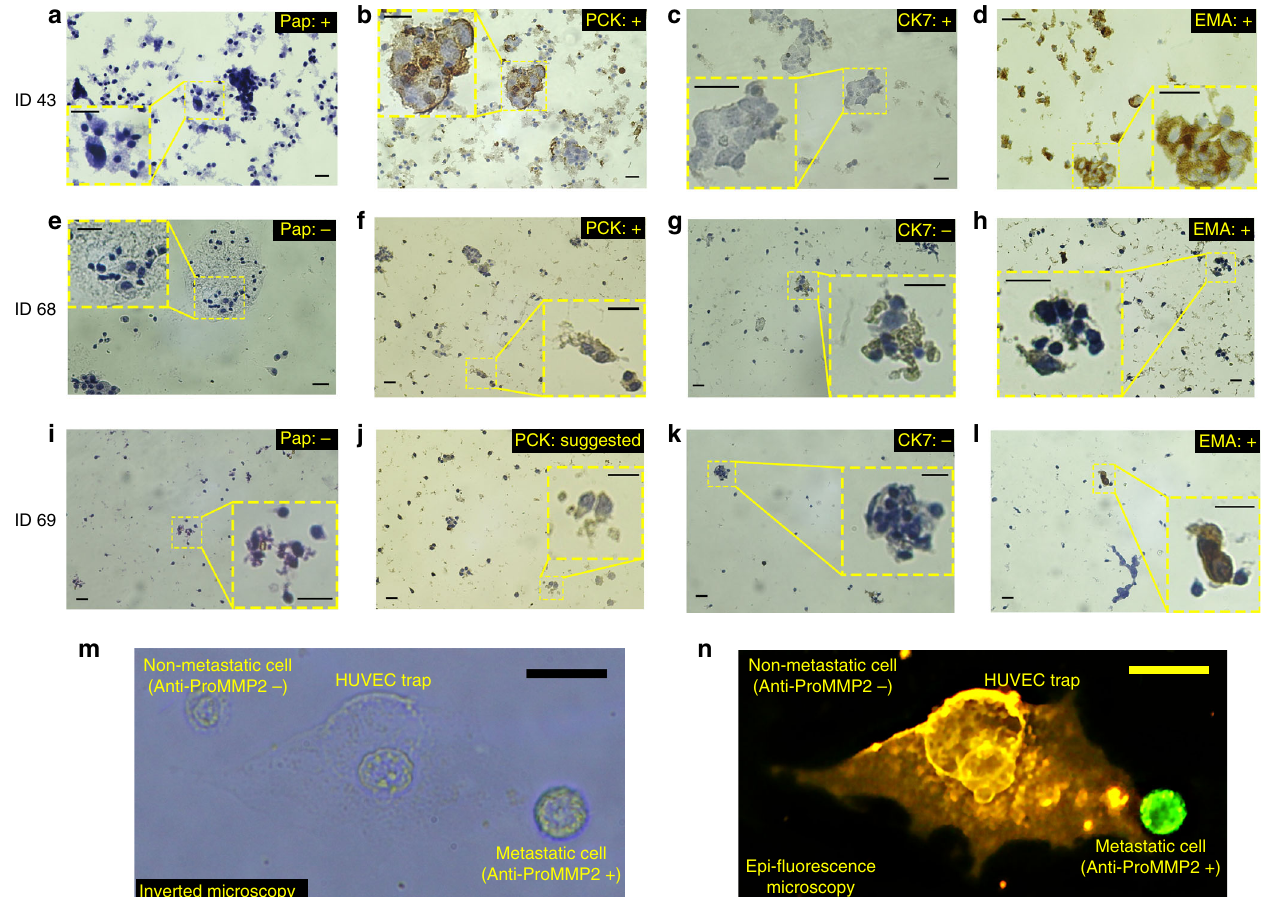
Fig. 5 Cytopathological and immunohistochemical images of the lymph node aspirated from a known metastatic sample (ID 43) positively scored by Metas-Chip in comparison with the similar assays from two suspicious aspirated samples (ID 68 and 69) negatively scored in Pap stain, but positively scored by Metas-Chip and IHC. a Cancer cells with large hyperchromic nucleus present metastatic carcinoma, meanwhile no trace of malignant cells could be observed in ( e , i ). Expression of PCK in the cancer cells are observable in metastatic ( b ) and one of the suspicious patients ( f ). Also the expression of PCK is suggestable in lymph of other suspicious patient ( j ). Expression of CK7 was positive in patient ID 43 ( c ) while it is negative in patient ID68 ( g ) and ID69 ( k ). Positive expression of EMA is observed in known metastatic ( d ) and suspicious patients ( h , l ). At least one IHC marker was positive in the suspicious patients who had been positively scored by Metas-Chip. Expression of metastatic epi fl uorescent marker (anti-proMMP2) on malignant cells invaded HUVEC trap. m Optical microscopy and ( n ) epi fl uorescence image of live single-HUVEC trap (stained by Dil: yellow) and breast cancer cells tagged for MMP2 (by anti-proMMP2: green) proteins presented in the surface of metastatic cells. Both of the cancer cells could be observed in optical images, but just one of them expressed the marker as active metastatic cells could be traced in epi fl uorescent image. Epi fl uorescent images of metastatic cell (expressed the marker) 90 min after invading the individual HUVEC trap showed entrance of the metastatic cell to vascular barrier . The scale bars